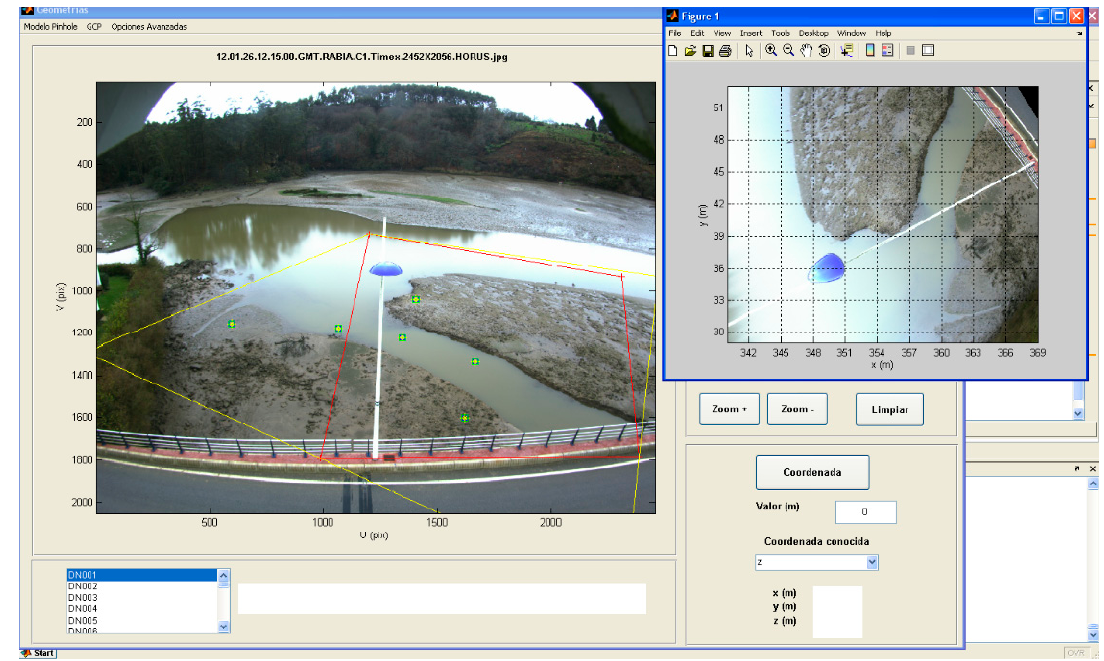
Figure 9. Selecting the region of interest (red square – left) and obtaining the rectified image (right).